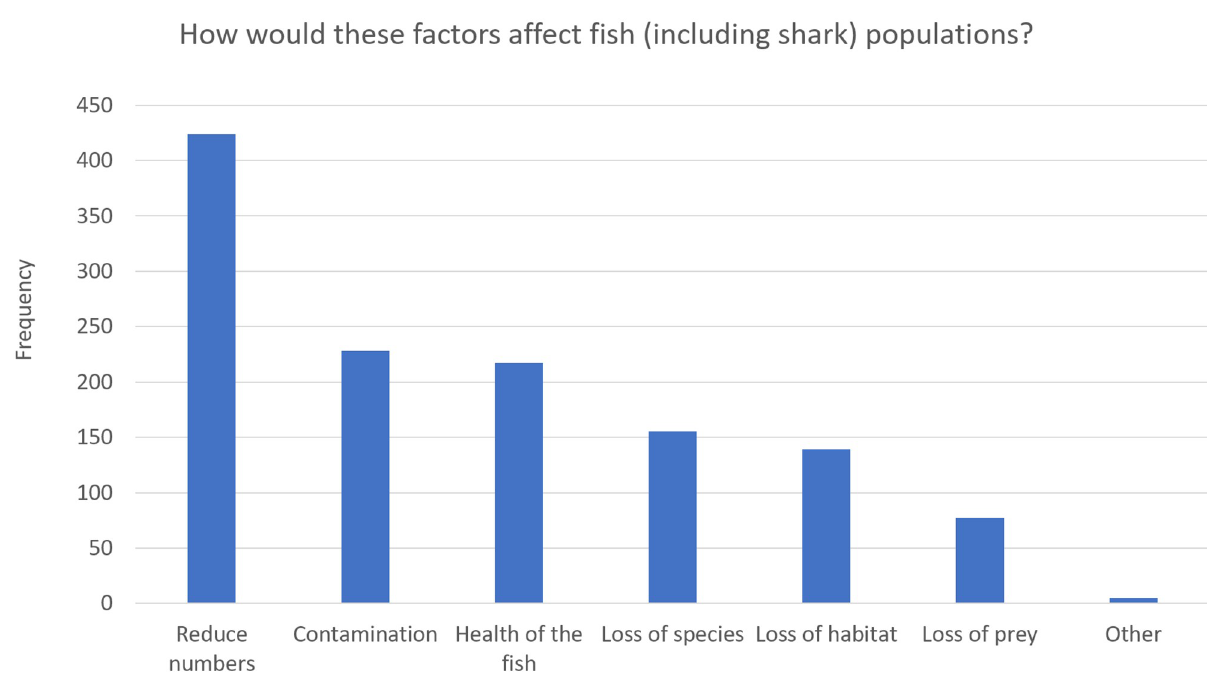
Fig 2. Frequency and percentage of respondents who correctly identified ways in which anthropogenic disruptions might affect fish/shark populations in Trinidad and Tobago. (See S3 Appendix for Table).